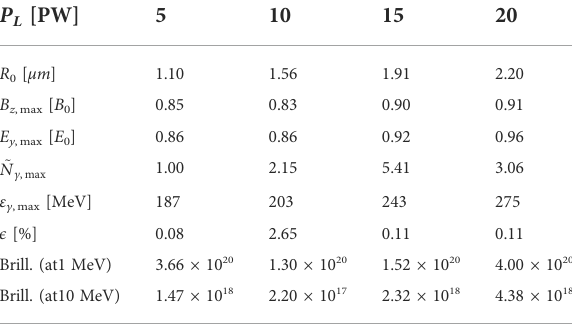
TABLE1Tableofcharacteristicsimulationresults fortheplanartarget with a 0 =350 laser pulse of duration τ =20 fs, rounded to second digit, except maximum photon energy ε γ ,max . Maximum values depict the overall maximum of that value during the whole simulation. ~ N γ , max (cid:1) N γ , max / N 5PW γ , max is the maximum photon count during the simulationnormalizedtothe5